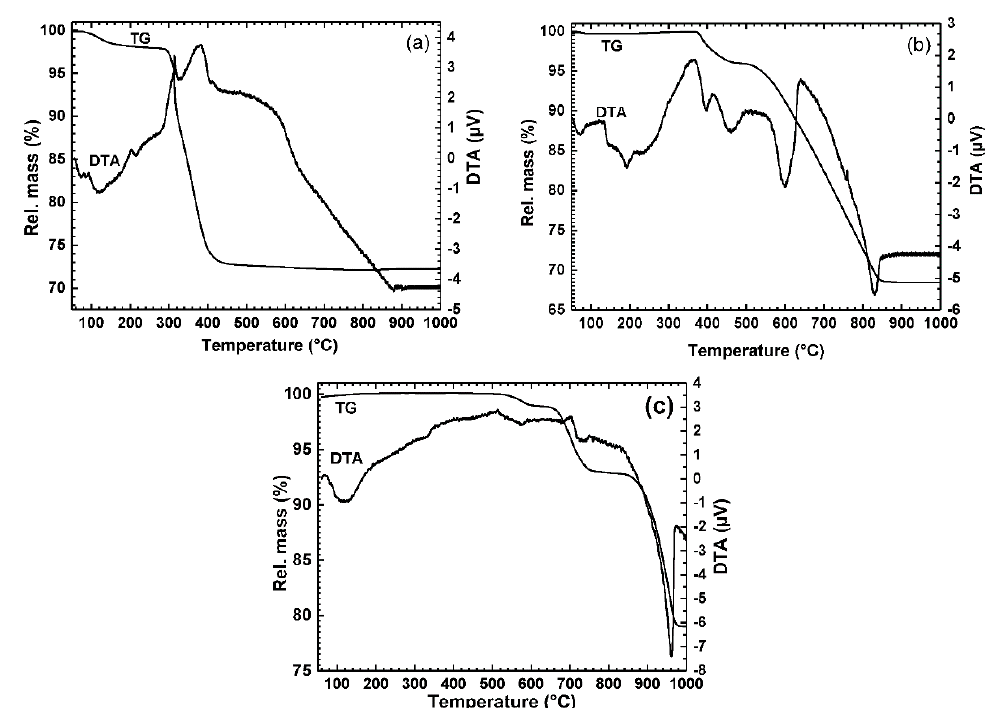
Figure 3. Non-isothermal reduction of nanosized metal oxides reduced with H 2 : ( a ) NiO; ( b ) Fe 2 O 3 ; ( c ) WO 3 .